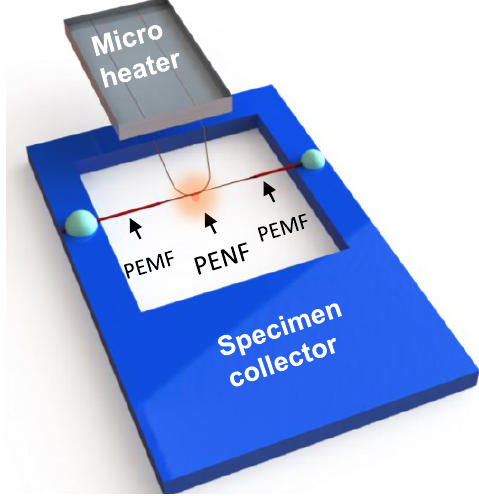
Figure 2. Schematic of the specimen collector and the fabrication of an ultra-high molecular weight polyethylene (UHMWPE) nanofiber (NF). Adapted from reference [3] supplementary information.